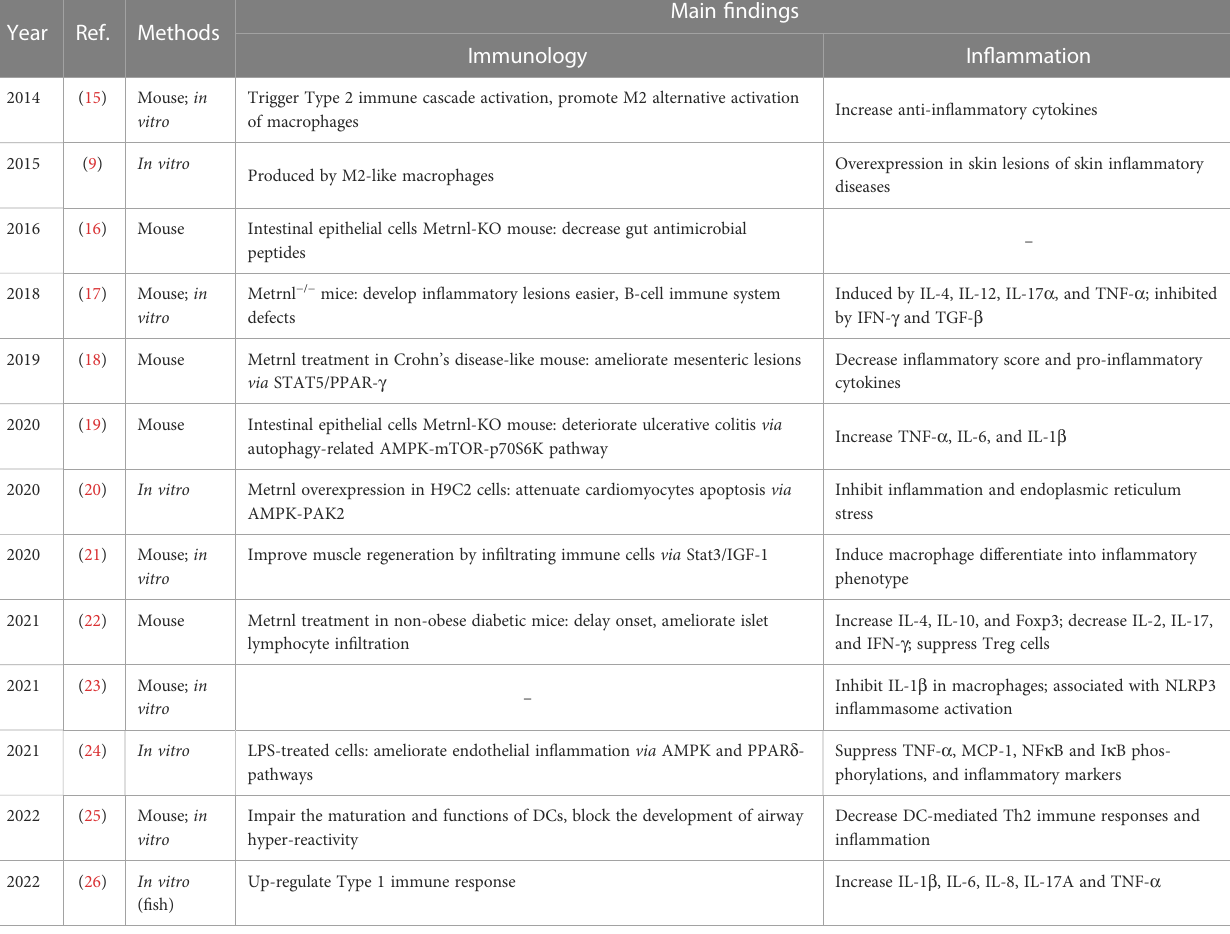
TABLE 1 Summary of preclinical studies associated with Metrnl in in fl ammation and immunology.